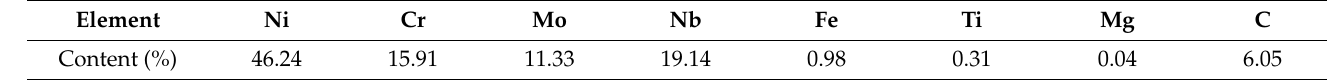
Table 5. Surface element content of the Inconel 625 weld cladding after corrosion for 10